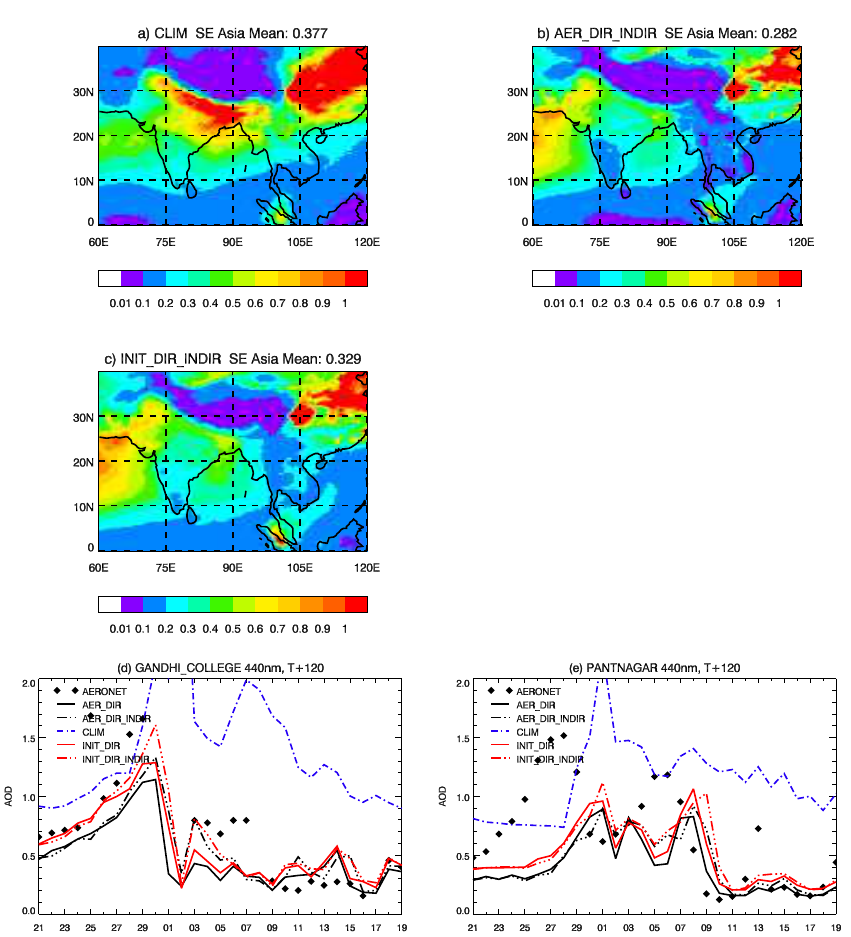
Fig. 19. AOD at 440nm South Asia at T + 120 from (a) CLIM, (b) AER_DIR_INDIR-CNTRL, (c) INIT_DIR_INDIR, time series of all Fig. 19. AOD at 440 nm South Asia at T +120 from (a) CLIM, simulations and AERONET observations at (d) Gandhi College and (e) (b) AER DIR INDIR-CNTRL, (c) INIT DIR INDIR, timeseries of all simulations and AERONET observations at (d) Pantnagar and (e) Gandhi College.